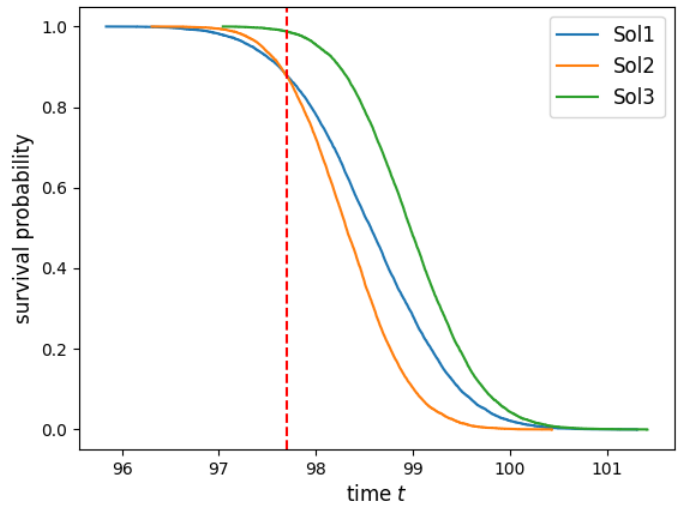
Figure 5. Survival function for instance p7.4.t.